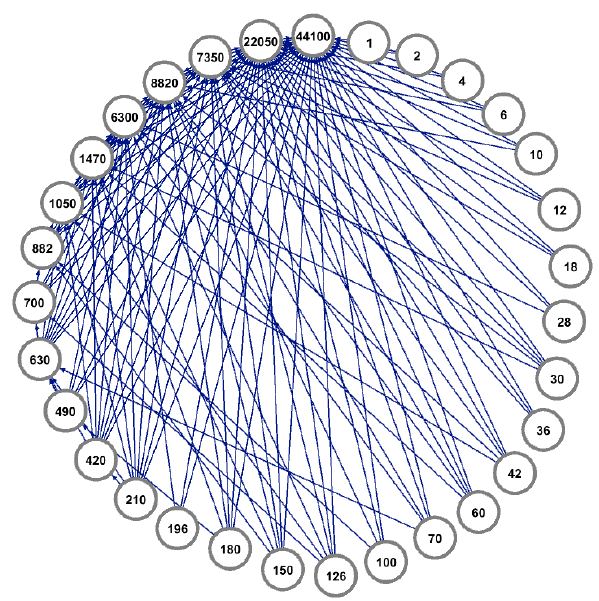
Figure10. Congruencegraphfor λ 0 (cid:0) 44100 Figure 10. Congruence graph for λ 0 = ConflictsofInterest: “Theauthorsdeclarenoconflictofinterest." 328